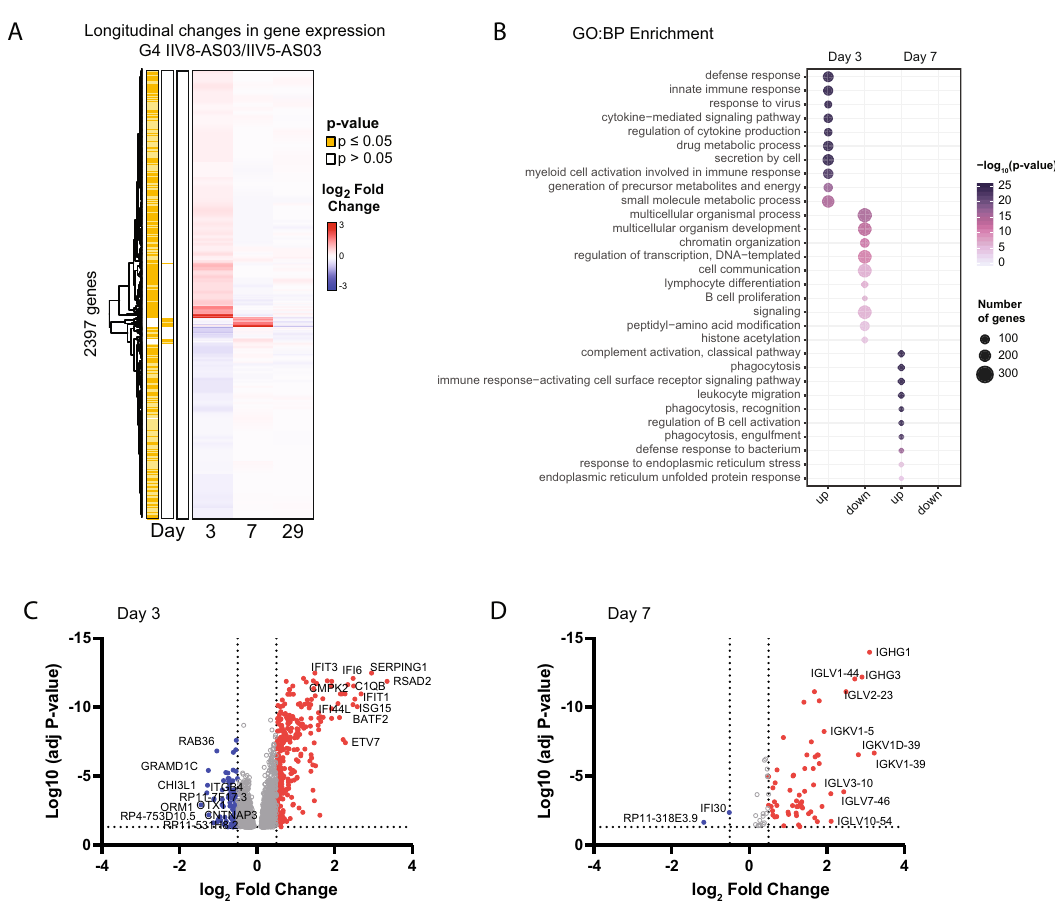
Fig. 3 Longitudinal transcriptional pro fi le of IIV8/AS03-IIV5/AS03 vaccination group (G4). A Heatmap of DEG changes on day 3, 7, and 29 of subjects of G4. Average fold change relative to baseline levels is shown and statistically signi fi cant differences are highlighted in yellow (Bayes adjusted p value ≤ 0.05, corrected for multiple testing using the Benjamini-Hochberg (BH) method). B Gene ontology (GO) enrichment analysis of differentially expressed genes (DEGs) on day 3 and 7 priming with IIV8/AS03. Diagram shows the top 10 enriched biological processes. Gene ontologies are ranked by their signi fi cance and dot size indicates overlap on number of genes. C , D Volcano plots of upregulated (red) and downregulated (blue) genes. Expression differences > 1.5-fold change (FC) are highlighted (log 2 FC ≤ 0.5, vertical dotted lines). The names of the top 10 genes are shown. Source data referring to A-B are provided as a Source Data fi